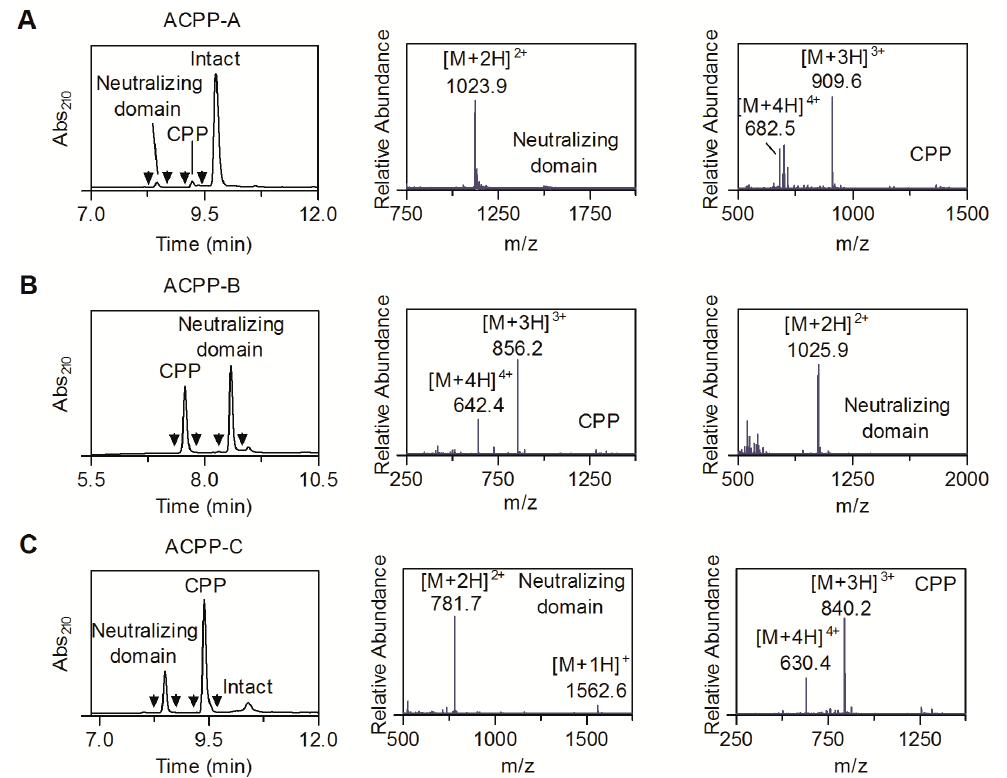
Figure 3. LC-MS characterization of ACPP-A, ACPP-B, and ACPP-C (0.1 mM) incubated with MT1-MMP (0.13 µM) for 60 min. The left and right graphs show the UV absorbance chromatogram and the mass spectra of the UV-peaks bracketed by the arrowheads, respectively. ( A ) ACPP-A; MS spectra of Neutralizing domain (obsd. 2244.8 Da, calcd. 2244.8 Da for Ac-y-e 9 -X-C*PKESC*N-COOH), and CPP (obsd. 2724.7 Da, calcd. 2724.7 Da for H 2 N-LFVLKD-X-r 9 -dab(DOTA)-NH 2 ). ( B ) ACPP-B; MS spectra of CPP (obsd. 2565.5 Da, calcd. 2565.5 Da for H 2 N-LRDSG-X-r 9 -k(DOTA)-NH 2 ), and Neutralizing domain (obsd. 2049.8 Da, calcd. 2049.8 Da for Ac-y-e 9 -X-CRPAH-COOH). ( C ) ACPP-C (without SHPP functionality); MS spectra of Neutralizing domain (obsd. 1561.5 Da, calcd. 1561.5 Da for e 9 -x-PLA-COOH), and CPP (obsd. 2517.4 Da, calcd. 2517.4 Da for H 2 N-C mob WAR-X-r 8 -k(DOTA)-NH 2 ). C* represents cysteine residues that are linked via an intramolecular disulfide